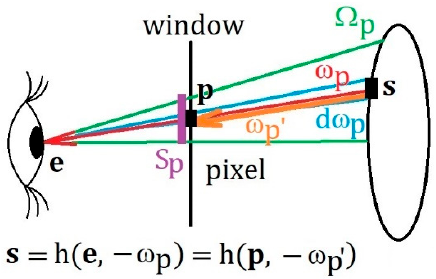
Figure 7. Conceptual diagram of a point on the object, a point on the screen (pixel) on which they are viewed, and an observation position.